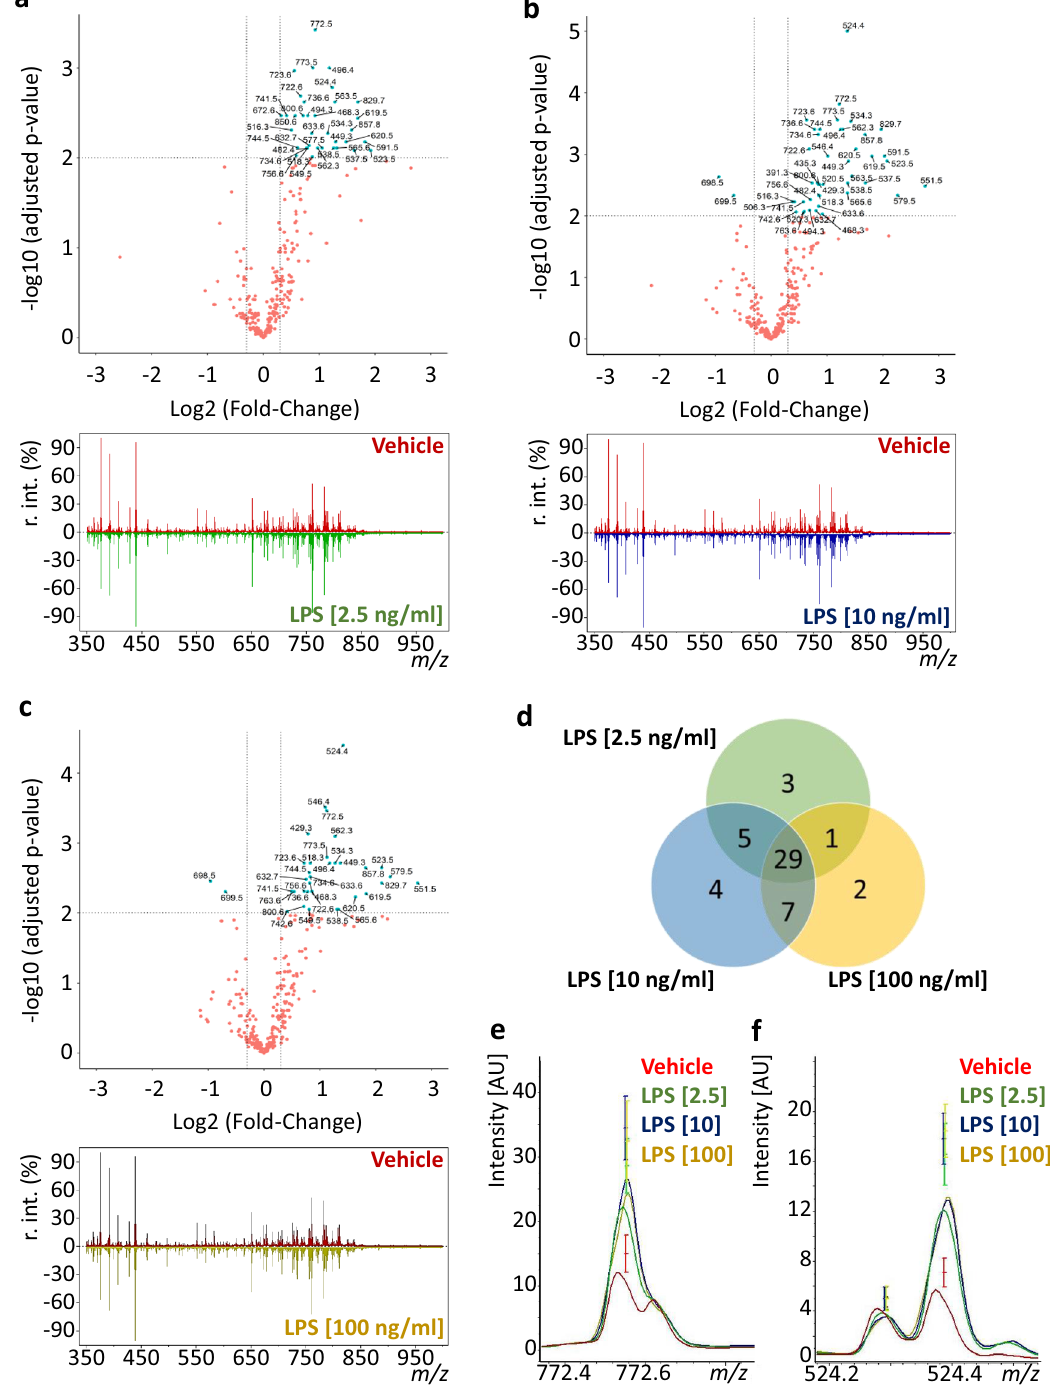
Figure 3. Fingerprinting of LPS-induced lipid responses in activated SIM-A9 microglial cells. ( a )–( c ) Log2- Fold-changes of putative lipids in VEH-treated versus LPS-stimulated microglial cells assessed by MALDI-TOF MS. Positive ion mode average mass spectra ( m/z -range 350–1000 Da; SNR > 3) and respective volcano plots. From a total of 298 signals, the volcano plots display 38, 45 and 39 putative lipid species as significantly changed compared to vehicle control for LPS concentrations of 2.5, 10 and 100 ng/ml, respectively. Differential signals (blue) and non-differential signals (red) were determined under the conditions of log2 fold-changes ≥ 0.3 or ≤ 0.3 and Welch’s T-Test and Benjamini & Hochberg adjusted p-value threshold ≤ 0.01 ( N = 6 biological replicates with 4–8 technical replicates). ( d ) Venn diagram showing the number of m/z features significantly altered with up to three concentrations of LPS. ( e, f ) Averaged MALDI-TOF MS lipid fingerprints at m/z 772.55 ( e ) and m/z 524.38 ( f ) showing LPS-induced greatest